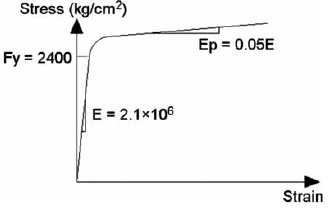
Fig. 14. Stress-strain curve for steel material (Asgarian, Jalilifar 2011)